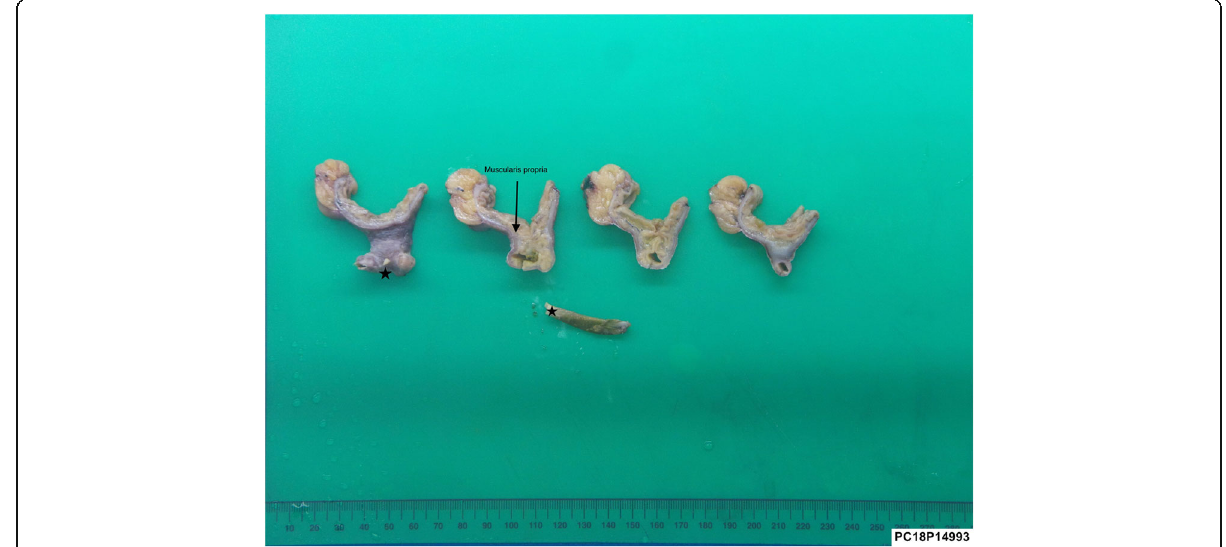
Fig. 5 Macro-photos of the diverticulum in cut sections, perforated by the chicken bone